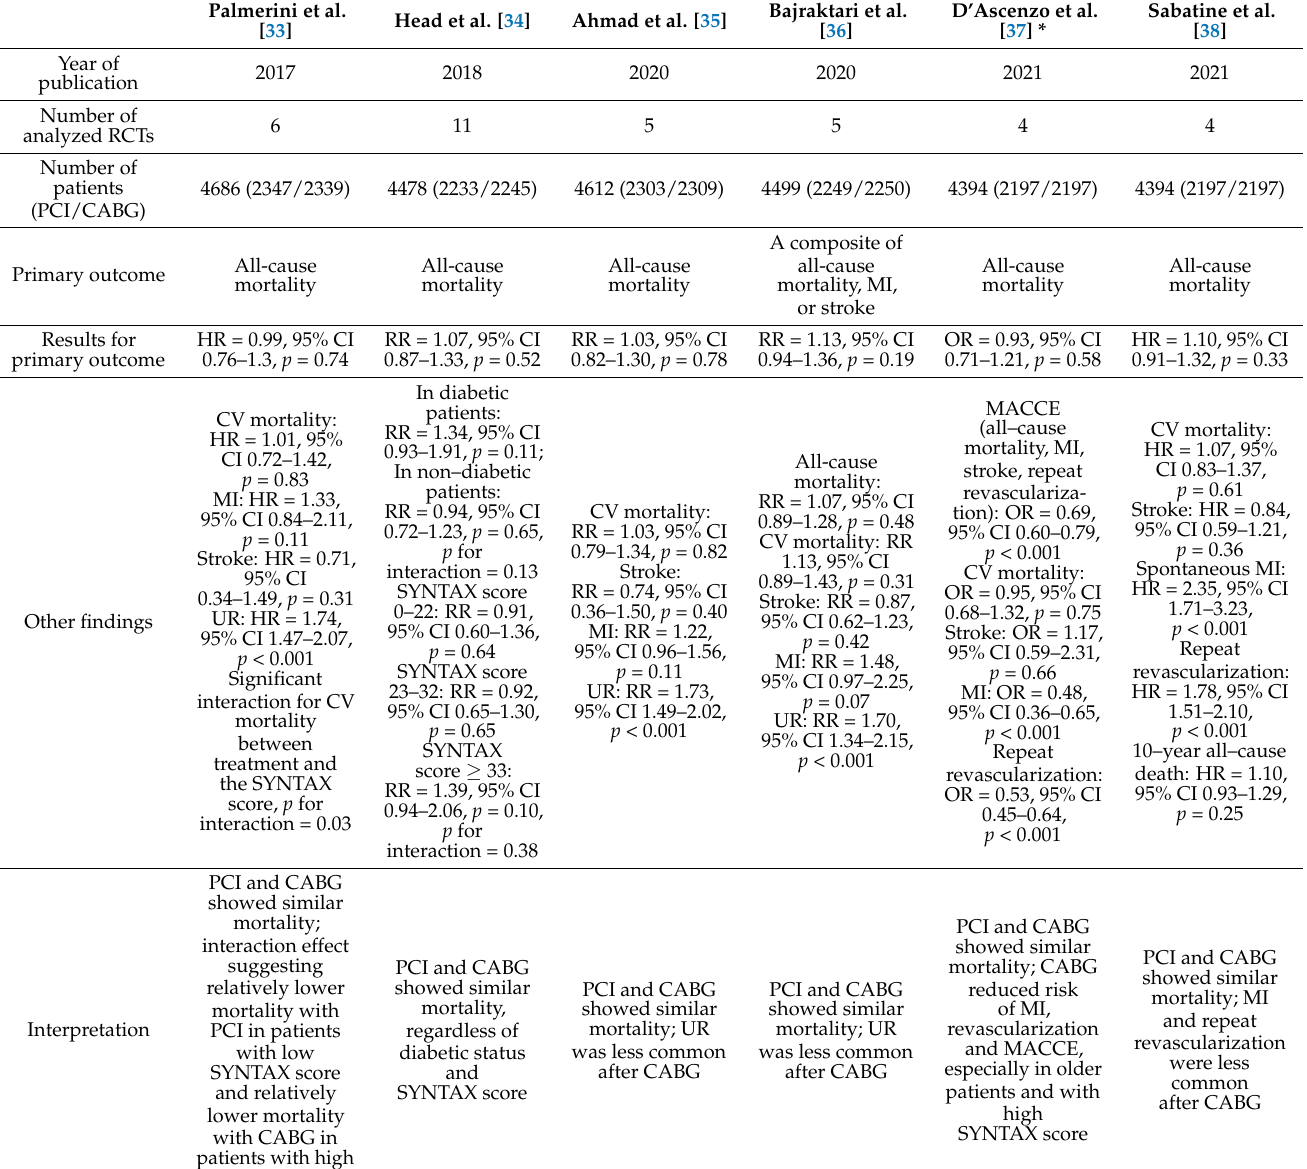
Table 2. The summary of selected meta-analyses of RCTs comparing PCI with CABG in LMCAD. Palmerini et al.